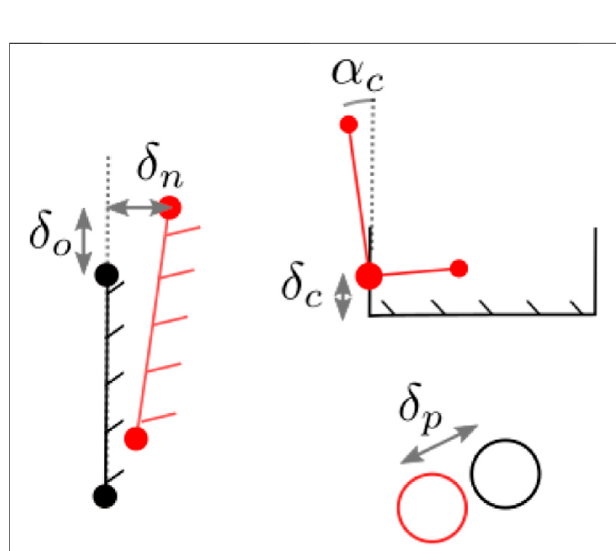
FIGURE 6 | The thresholds that are checked to decide if a hypothesis should be